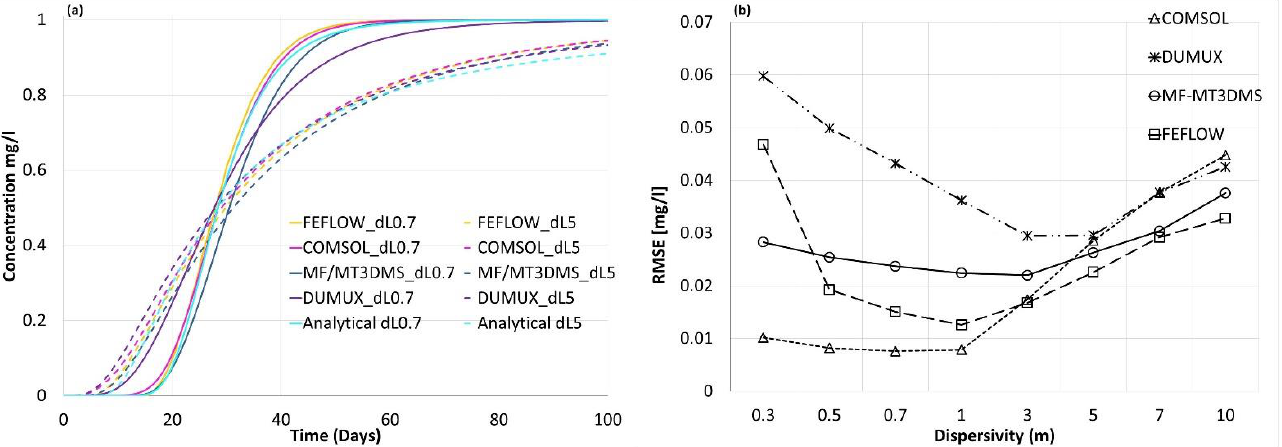
Figure 6. Simulated tracer concentration using MODFLOW/MT3DMS, FEFLOW, COMSOL Mul- tiphysics, and DuMu X at three different layers for Problem 3; ( a ) top layer; ( b ) middle layer; ( c ) bot- tom layer with a dispersivity value of 5 m.